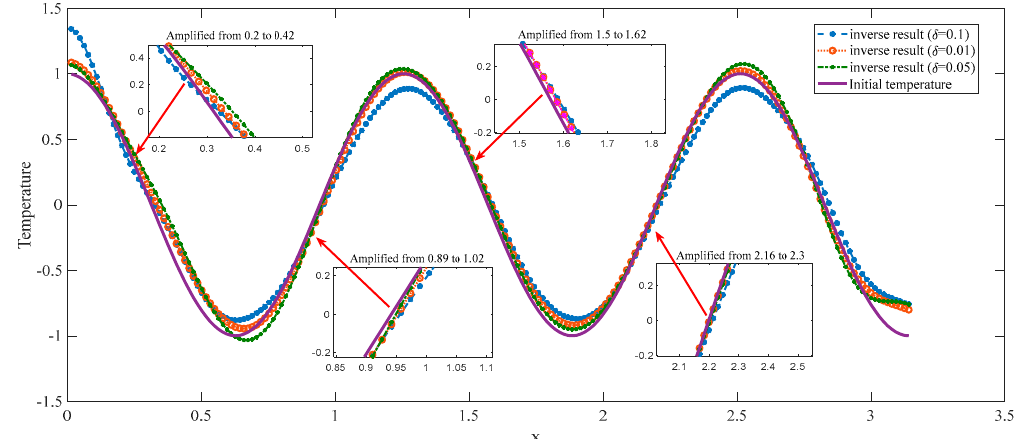
δ δ ( x , T ) with di ff erent δ with different δ . Figure 1. Recovery of u ( x ,0 ) from the measuring data u